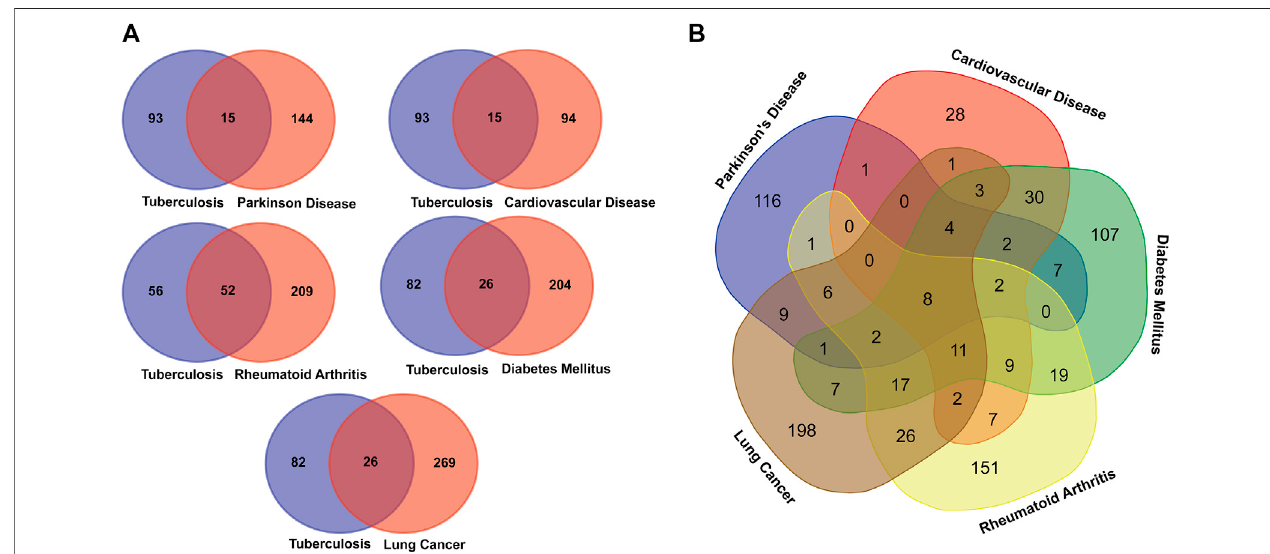
FIGURE2| Venndiagram showing thenumber ofoverlapped genesamongthe TBand overlappingNCDs. (A) Associationbetween Tuberculosis and NCDs. (B) . Overall disease gene association among the MTB and NCDs.